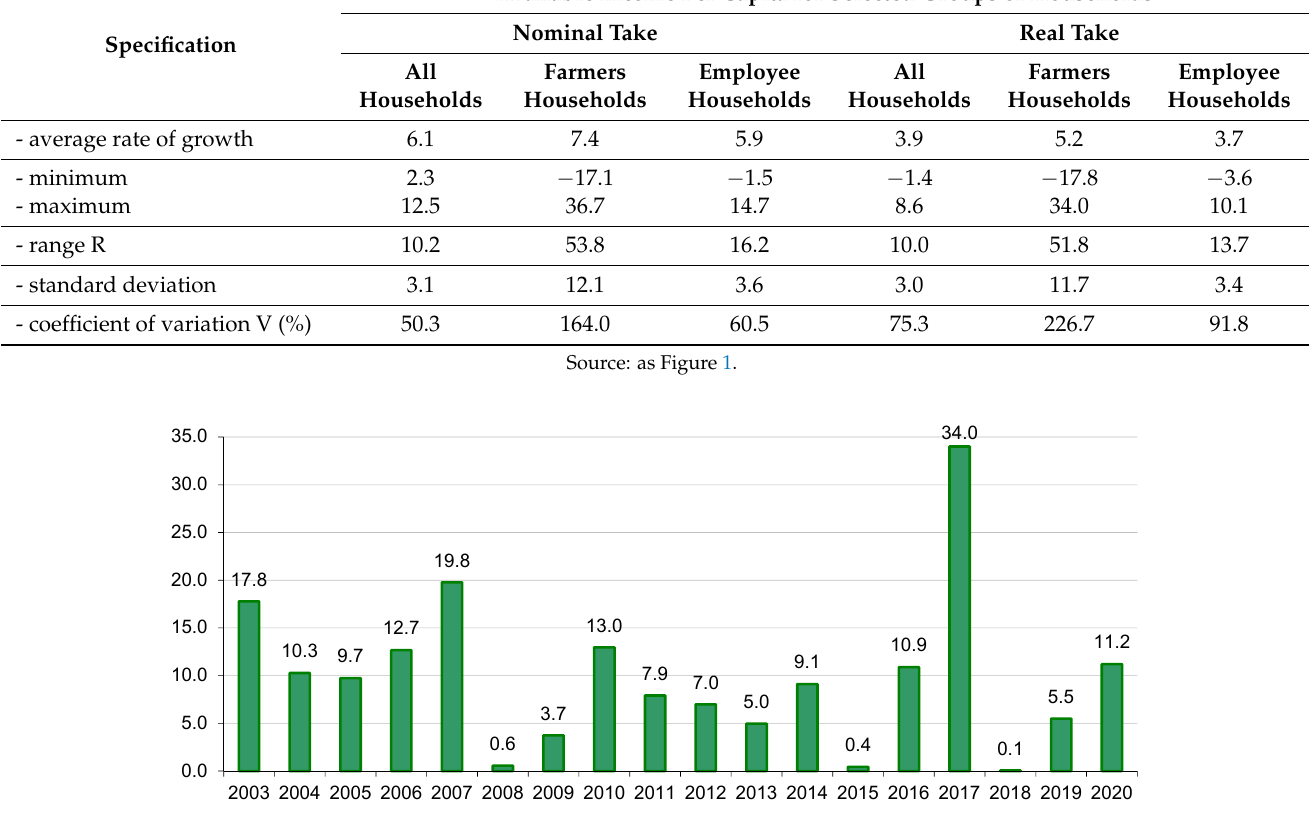
Figure 3. The absolute rate of change in the monthly nominal available income per capita in farmers’ households (in %). Source: as Figure 1.